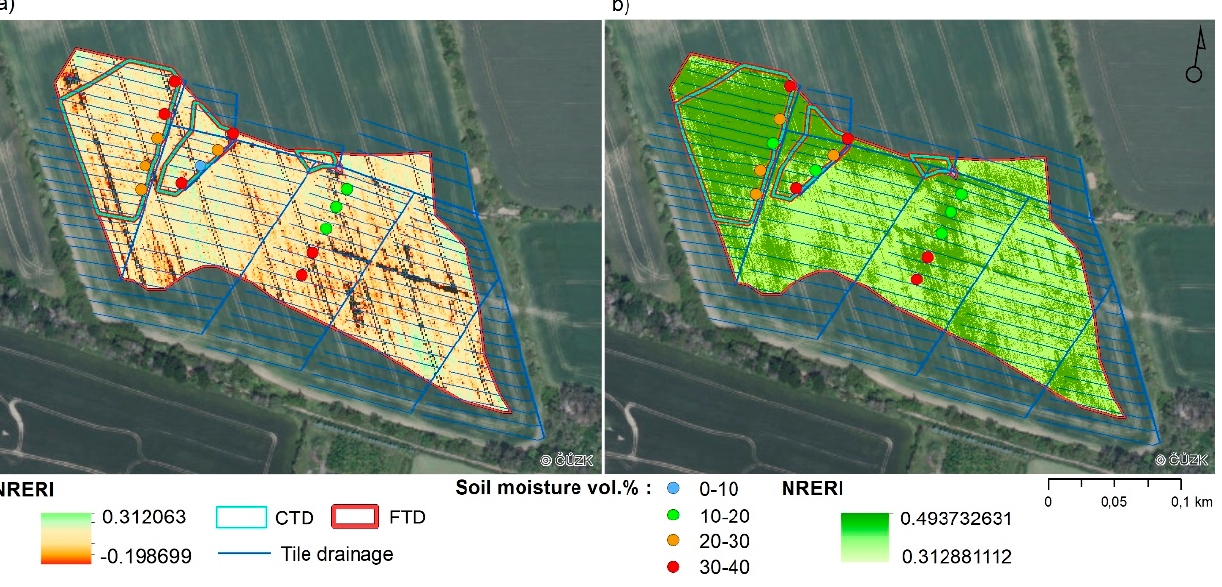
Figure 7. Distribution of NRERI and point soil moisture from 40 cm at CTD and FTD sites with